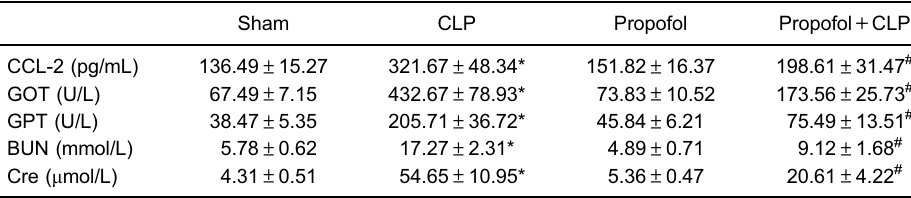
Table 2. Effects of propofol on hepatic and renal function in cecal ligation and puncture (CLP)-operated or sham-operated mice. Sham